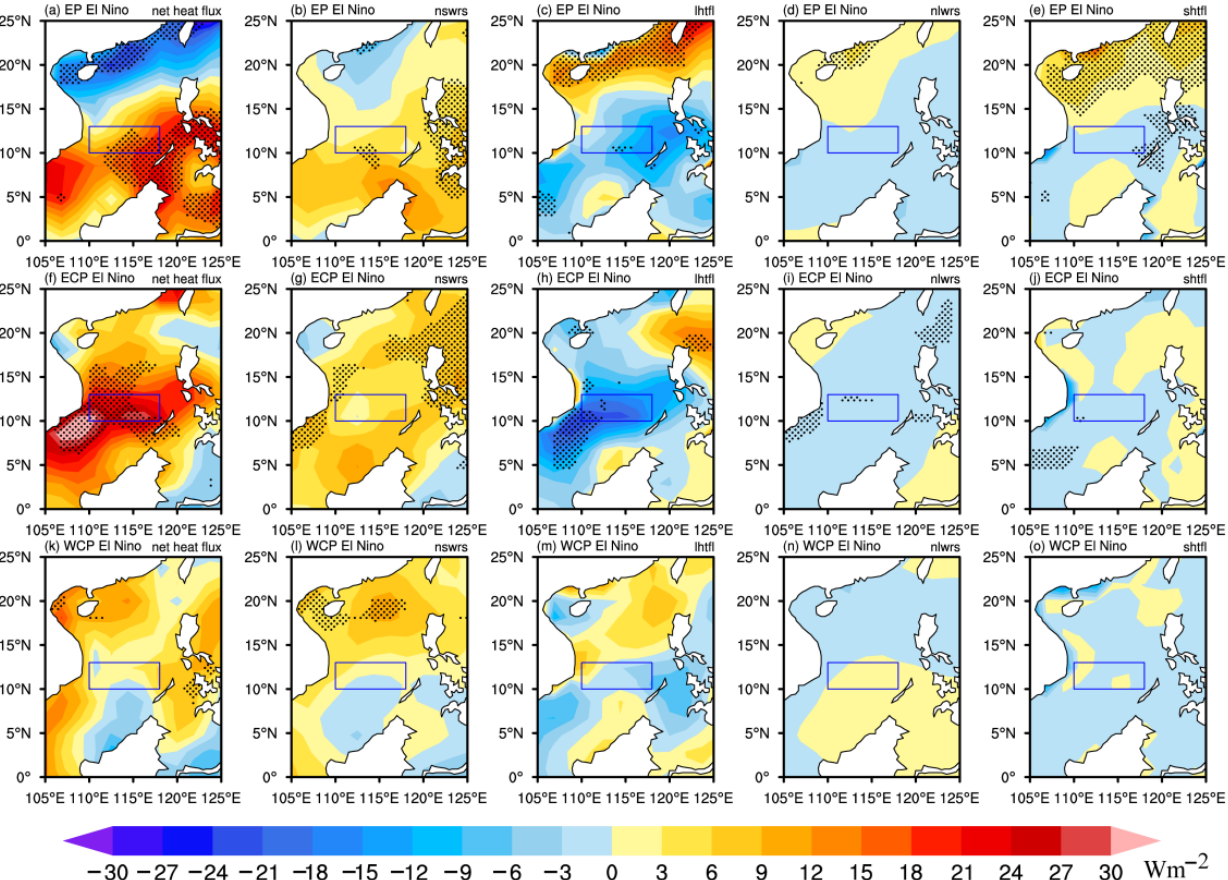
Figure 9. Composite MAM anomalies of net surface heat flux ( a , f , k ), short-wave radiation flux ( b , g , l ), latent heat flux ( c , h , m ), long-wave radiation flux ( d , i , n ) and sensible heat flux ( e , j , o ) (W · m − 3 ) over the SCS for EP El Niño ( a – e ), ECP El Niño ( f – j ) and WCP El Niño ( k – o ). The stippled areas represent the values exceeding the 90% significance level. Rectangles represent the CT region. Long-wave radiation, latent heat flux and sensible heat flux are upward positive and short-wave radiation is downward positive.